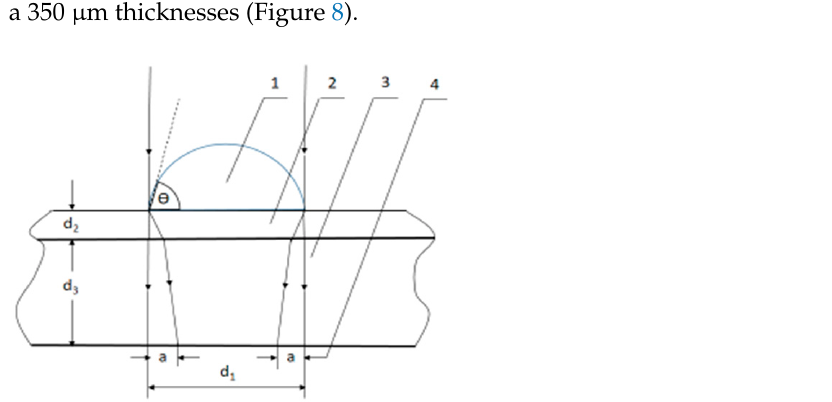
Figure 7. The EVObooster device for EVOdrop hydrogen water.